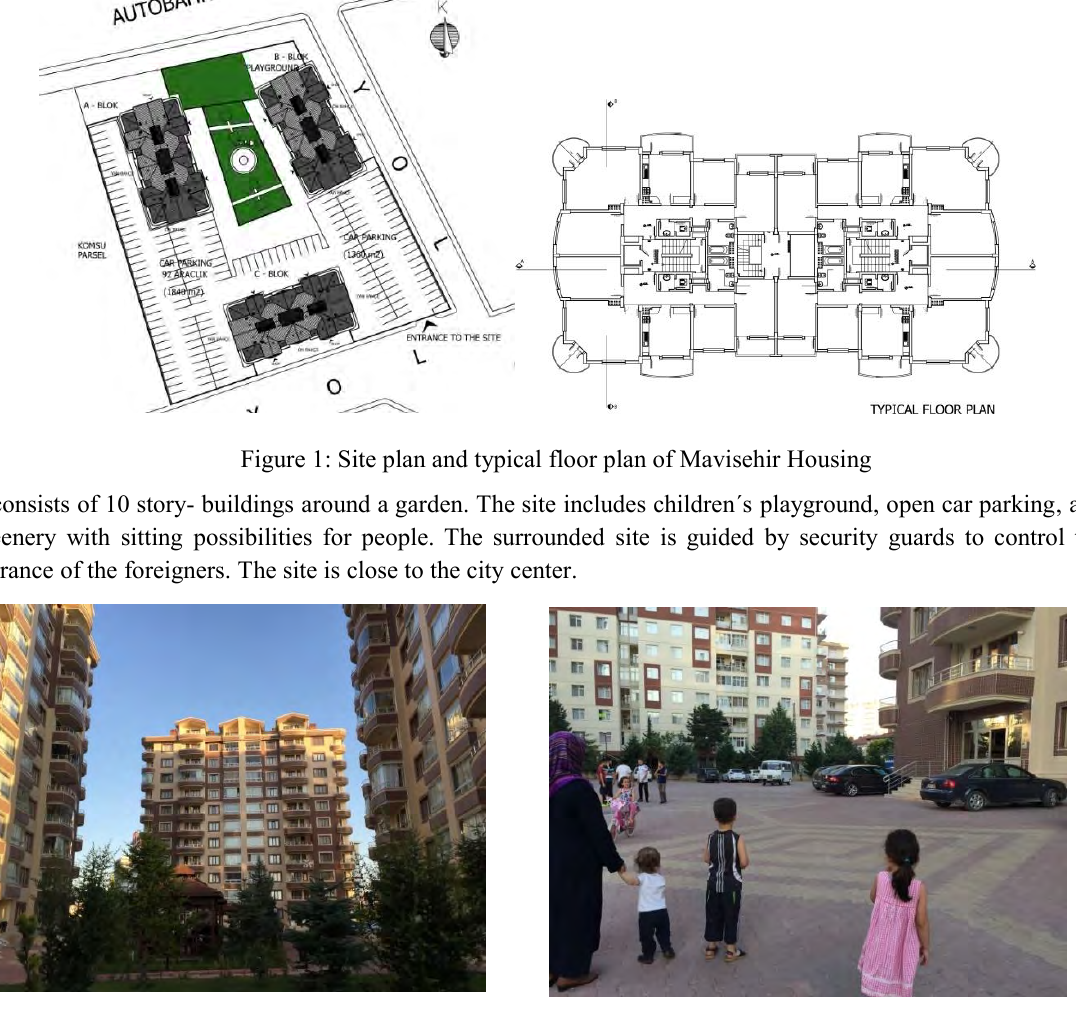
Figure 2: The general Image of the buildings Figure 3: Parking place in front of the buildings